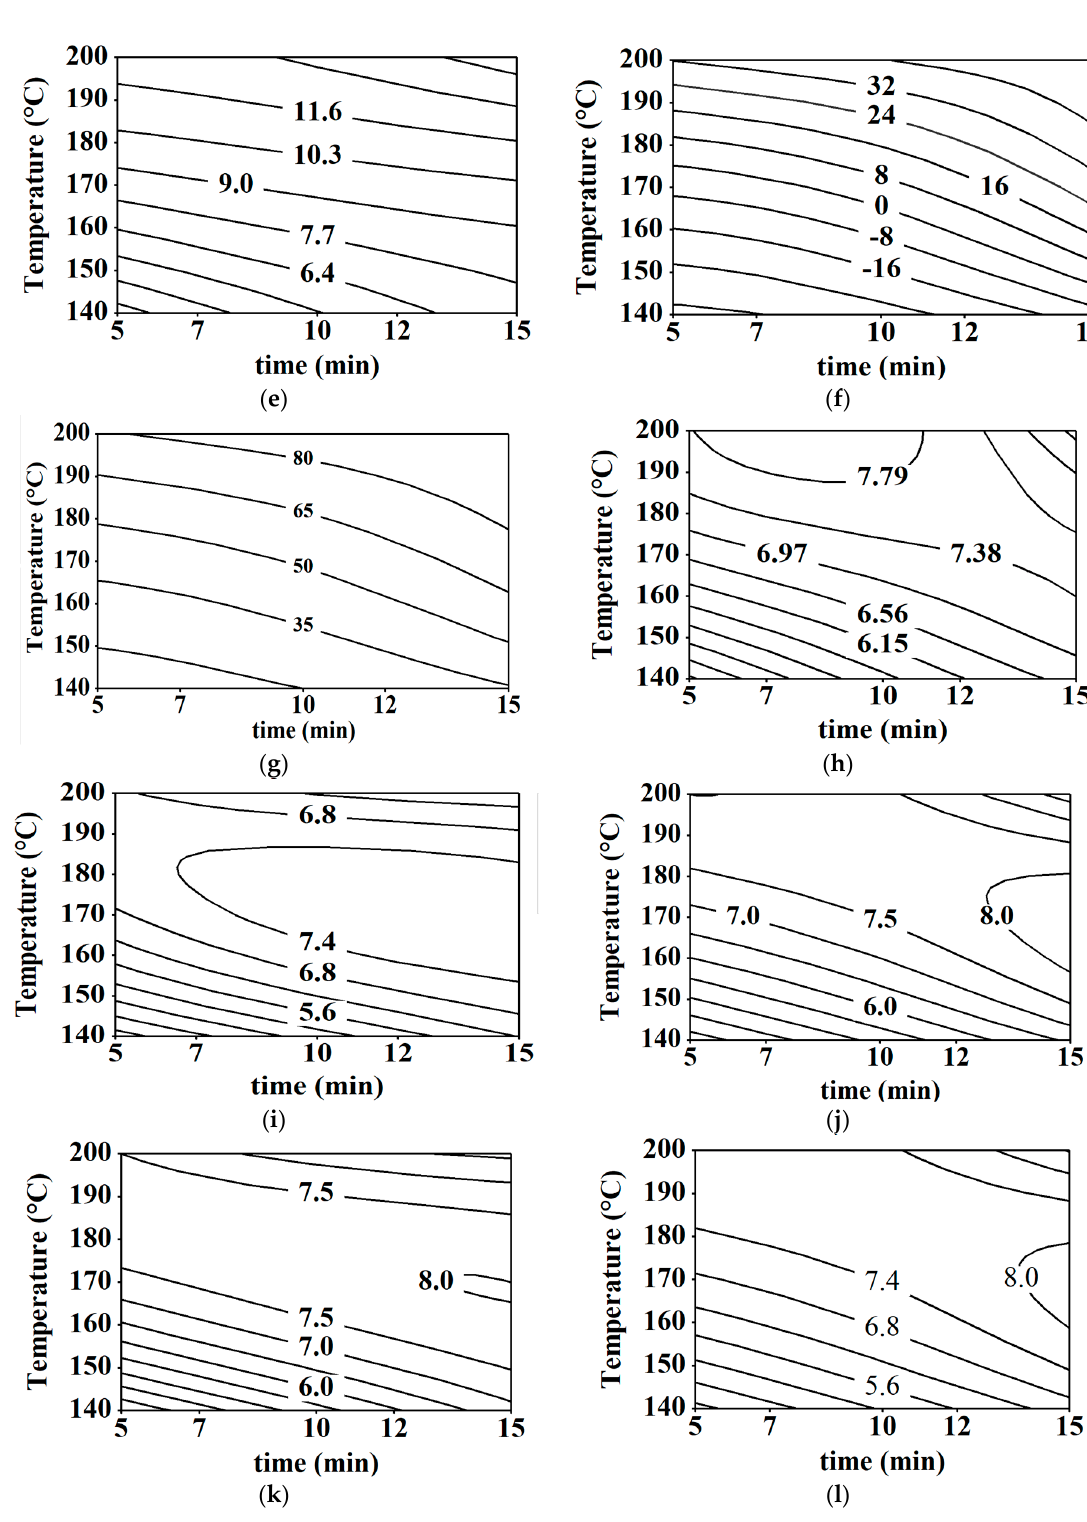
Figure 1. Contour plots for ( a ) moisture content (MC w.b. %), ( b ) fat content (FC %d.b.), ( c ) hardness (N), ( d ) L * -value, ( e ) a*-value, ( f ) b*-value, ( g ) Δ E, ( h ) appearance, ( i ) crispiness, ( j ) taste, ( k ) aroma, and ( l ) overall preference of the fried falafel at different frying conditions.